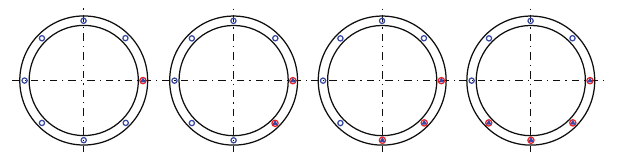
Figure 10: Schematic of bolt looseness sequence.